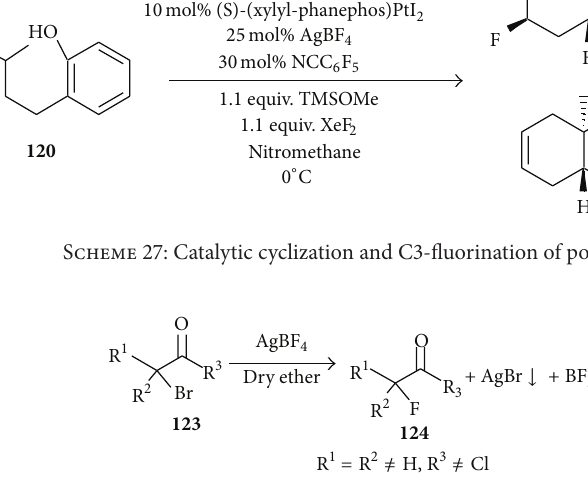
Scheme 28: Synthesis of 𝛼 -fluorocarbonyl compounds 124 .